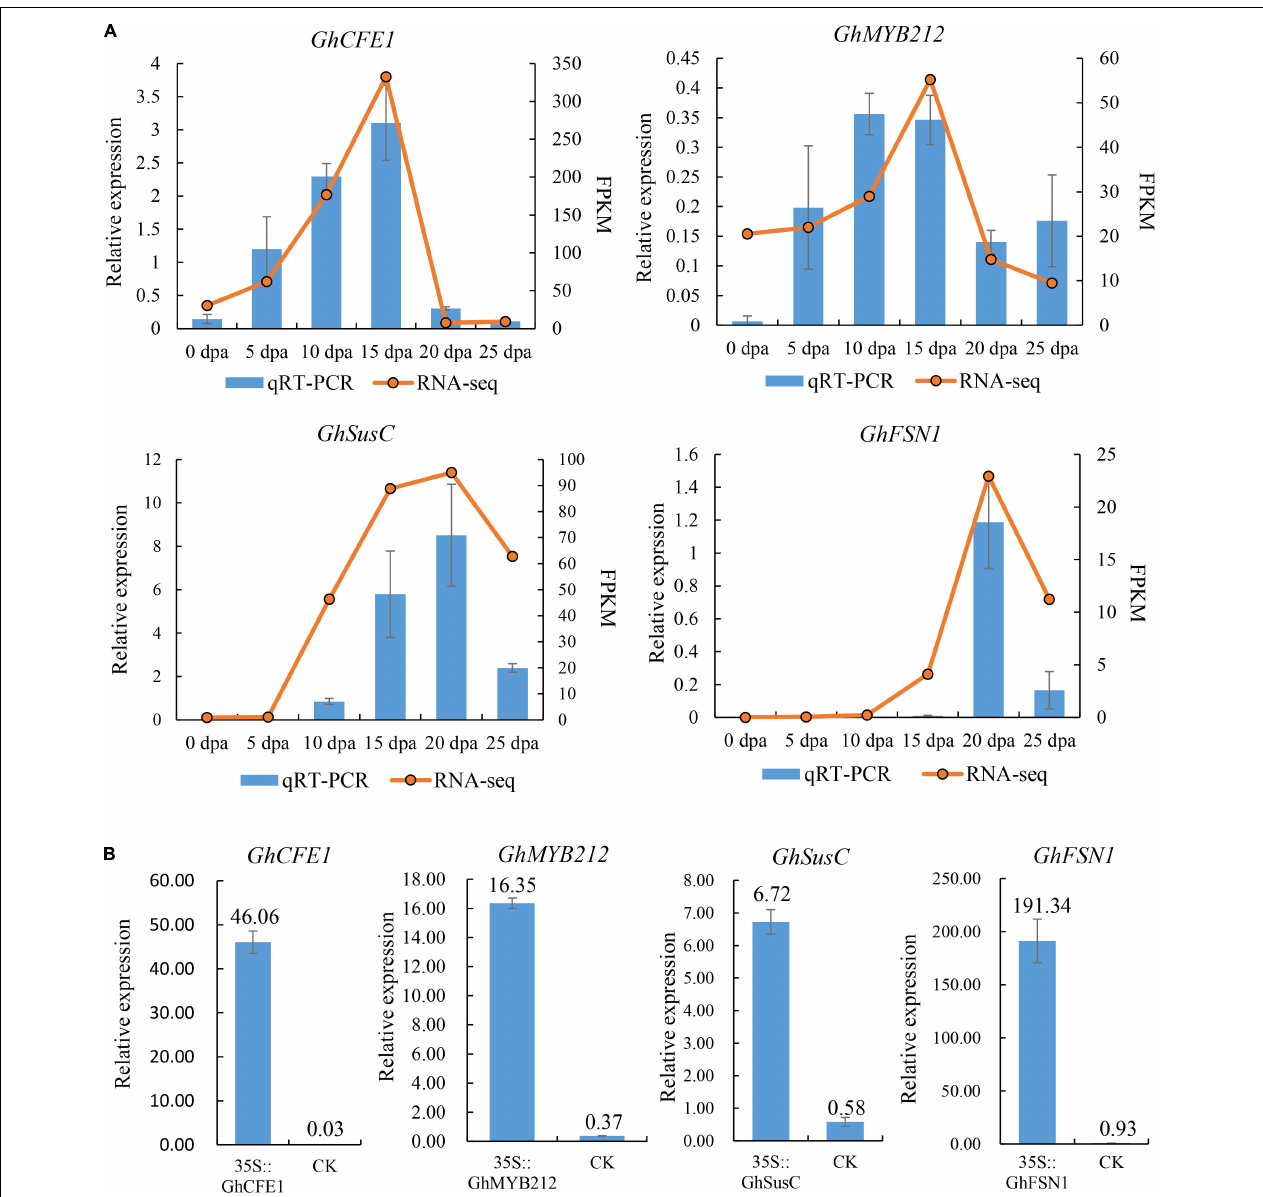
FIGURE 4 | Transient overexpression of four cotton genes in fibers. (A) The expression pattern of four genes used for transient overexpression experiment was investigated in Gossypium hirsutum TM-1, including two genes, GhCFE and GhMYB212 , which are preferentially expressed in elongating fibers, and two genes, GhSusC and GhFSN1 , which are preferentially expressed in secondary cell wall depositing fibers. (B) The expression levels of GhCFE1 , GhMYB212 , GhSusC, and GhFSN1 were significantly higher in transiently transformed fibers than that in the control, which was transformed with empty pBI121 binary expression vector, respectively. Data above each column indicate the relative expression of each gene compared with the internal reference gene, GhUBQ7 . Fibers at 20 DPA were used for transformation. Error bars indicate